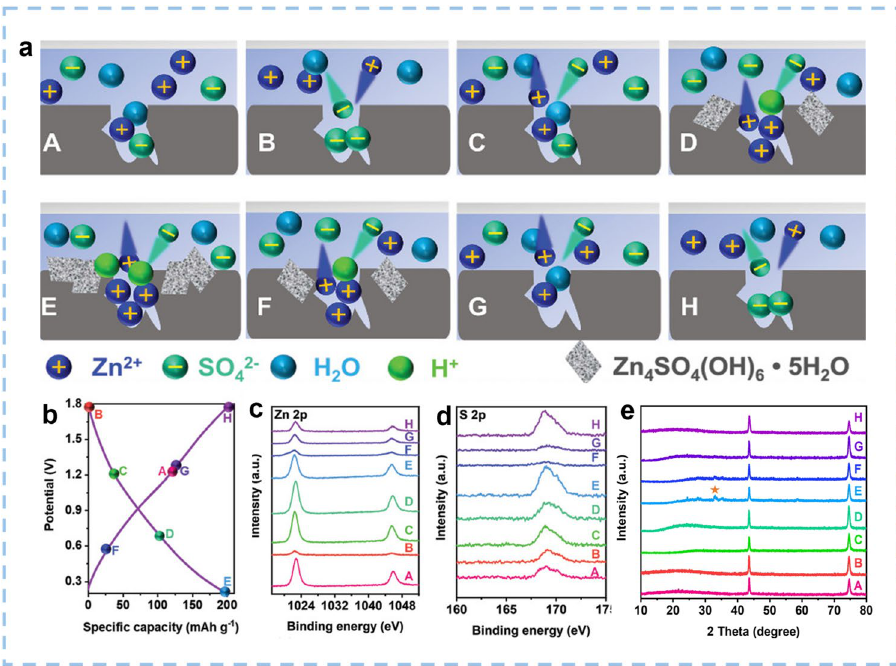
Fig. 3 The charge storage mechanism of ANHPC-2 in ZnSO 4 aqueous electrolytes at different charge/discharge states. a Schematic illustration of the charge storage mechanism for ANHPC-2 in 2 mol L −1 ZnSO 4 electrolyte. b Typical GCD curve at 0.5 A g −1 and corresponding ex situ. c Zn 2 p , d S 2 p , XPS spectra of ANHPC-2 cathode at the selected voltage points. e Ex situ XRD patterns of ANHPC-2 cathode at different stages. Reproduced with permission [84]. Copyright 2022,